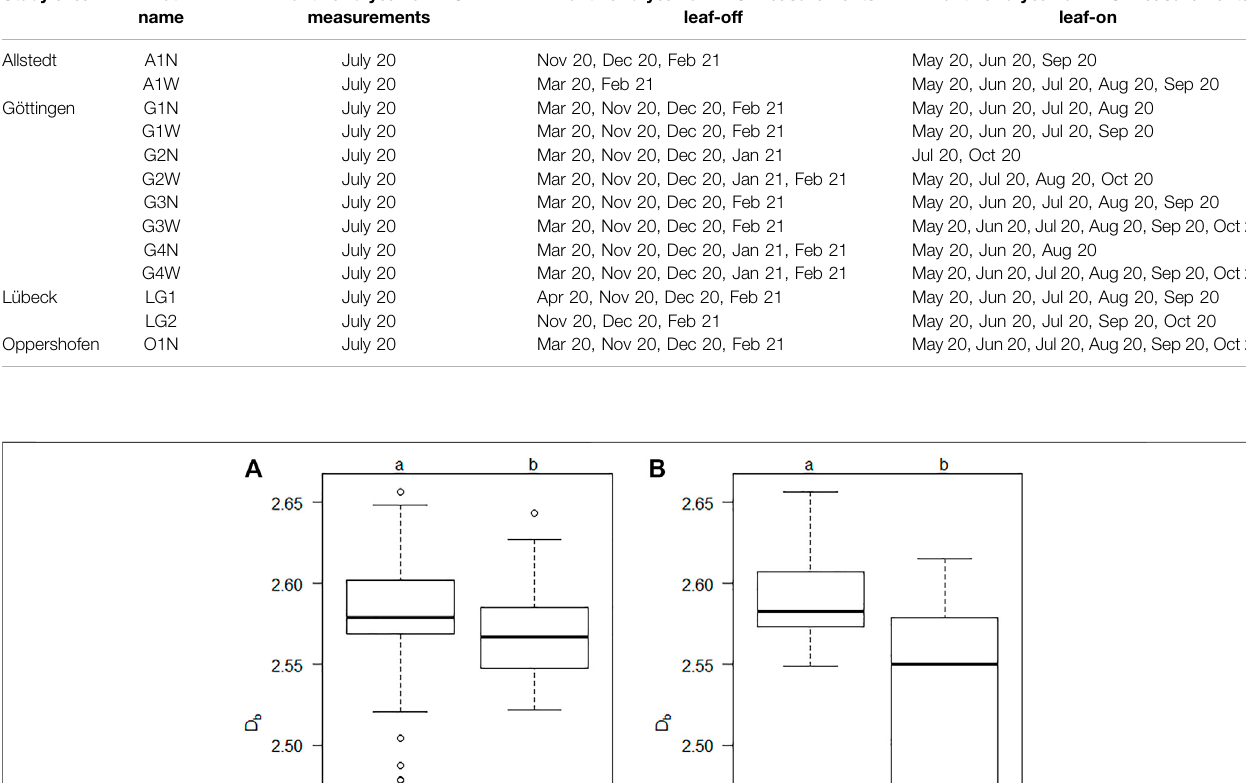
TABLE 4 | Data acquisition months for the TLS and MLS. Missing data is due to failed SLAM processing of the data after scanning. Study